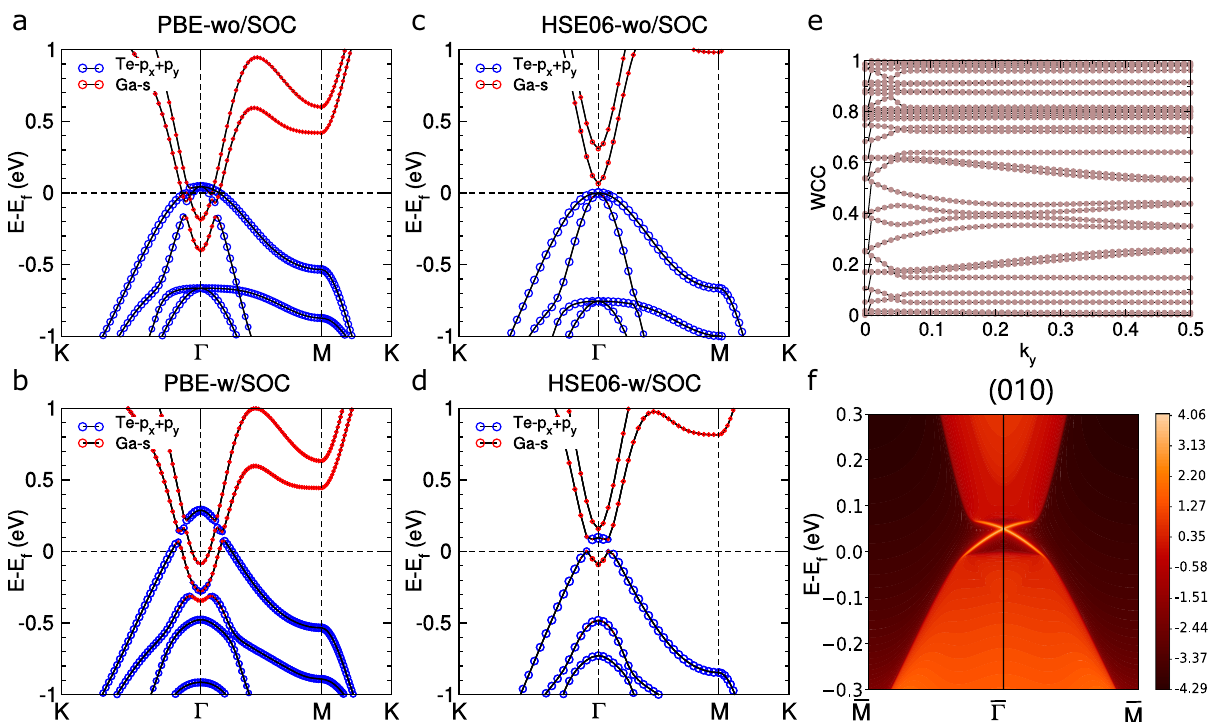
Fig. 3 Topological properties of β 2 -SrGa 2 Te 4 . a , b The band structures from standard DFT calculations without and with SOC, respectively. c , d The results of HSE06 calculations without and with SOC, respectively. The bands are weighted by the orbital projections of Te and Ga. e The evolution of the Wannier charge centers (WCC) in the k z = 0 plane. f Edge states of β 2 -SrGa 2 Te 4 for the HSE06